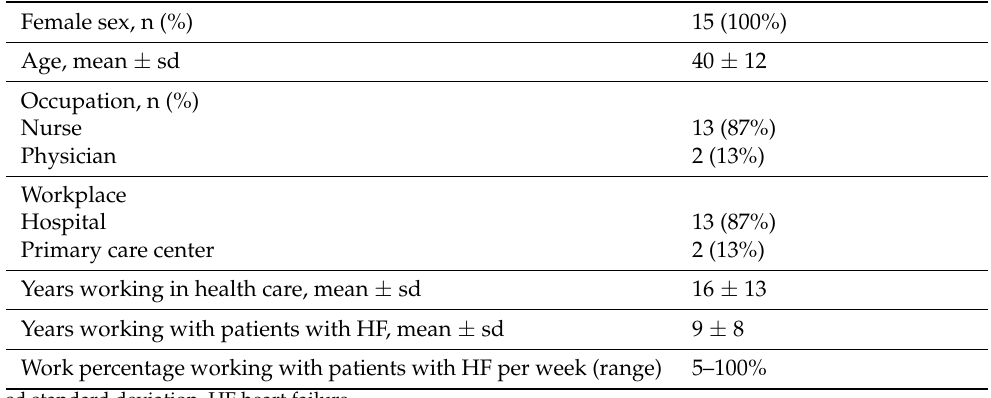
Table 1. Demographic data of the study